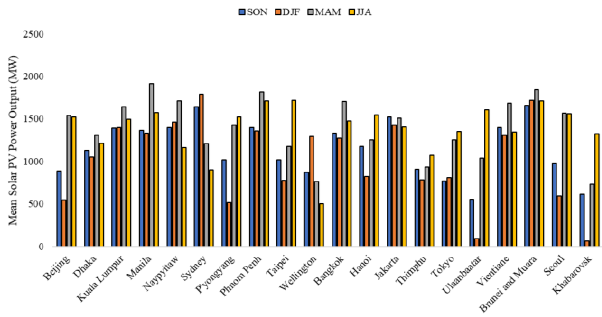
Figure 8. Effective mean seasonal solar PV power ( P’ PV ) output for selected cities in the Asia Pacific region.